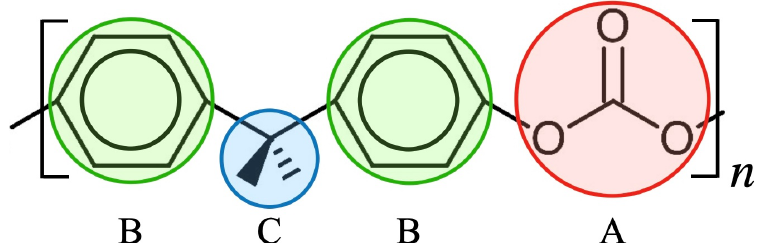
Figure 1. Formula unit of polycarbonate (PC) and its coarse-grained representation. Particles A, B and C represent carbonate, phenylene and isopropylidene, respectively, and order in B-C-B-A arrangement. The details of the bond length and bond angle are described by Kubo et al.